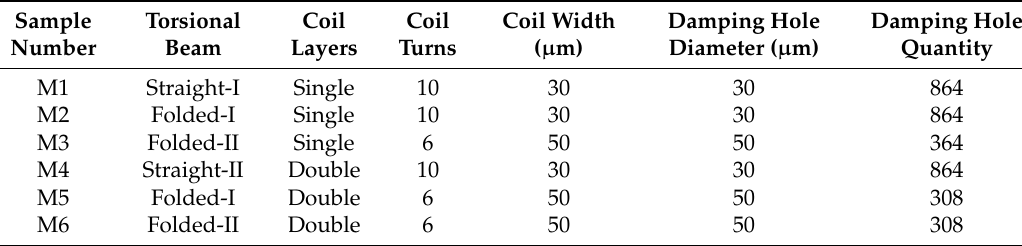
Table 1. Structural parameters of different magnetometer samples.